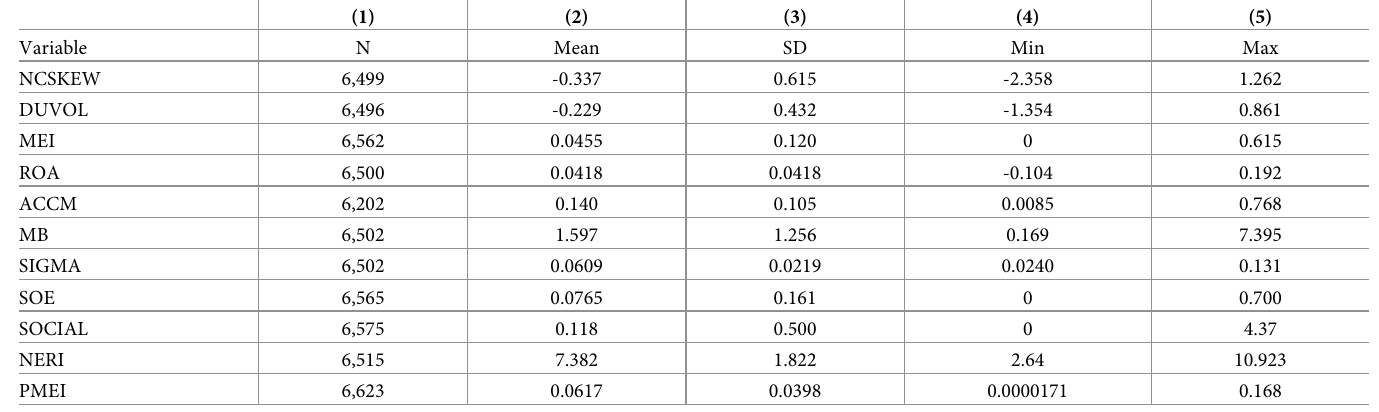
Table 1. Descriptive